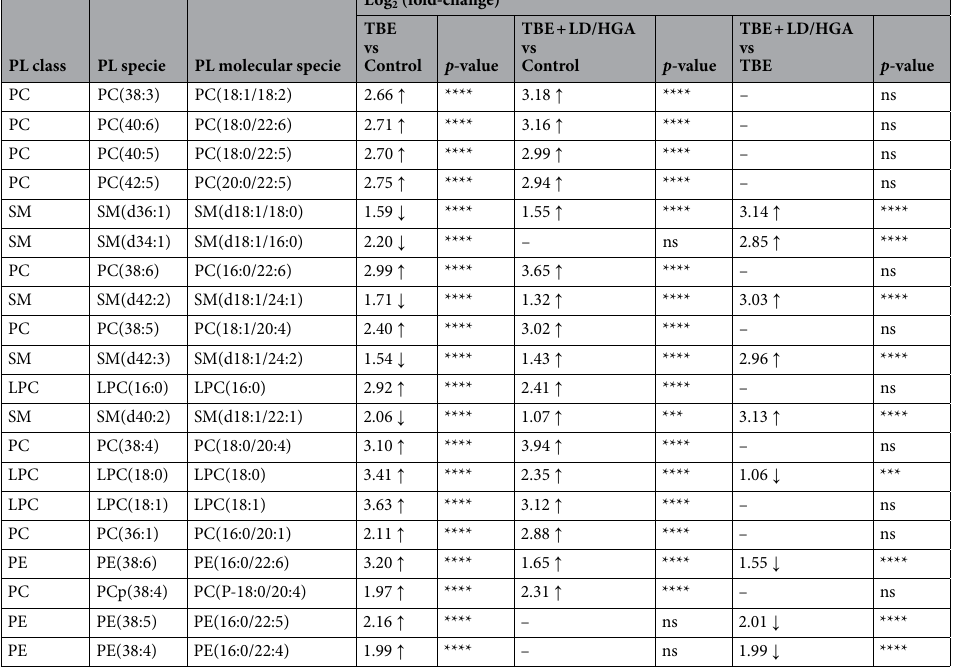
Table 3. The alteration observed in the molecular species of 20 most discriminating (according to One-way ANOVA) PL species from PC, LPC, PE and SM class in the plasma of healthy subjects (Control) and TBE patients (TBE) and TBE patients with co-infections (TBE + LD/HGA); mean difference was significant at the 0.05 level (p < 0.0001****; p < 0.001***; n.s.–not significant; the up arrows represent up-regulation and down arrows represent